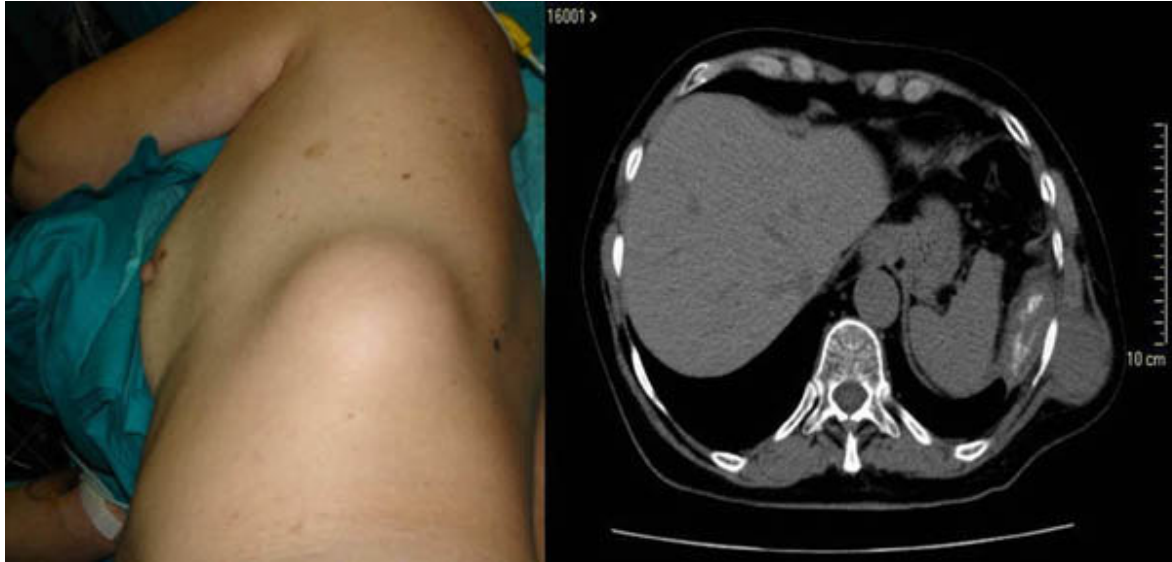
FIGURE 1. Empyema necessitatis. CT shows intrapleural, diaphragmatic, and chest localization due to a fistula in 8 th intercostal space.